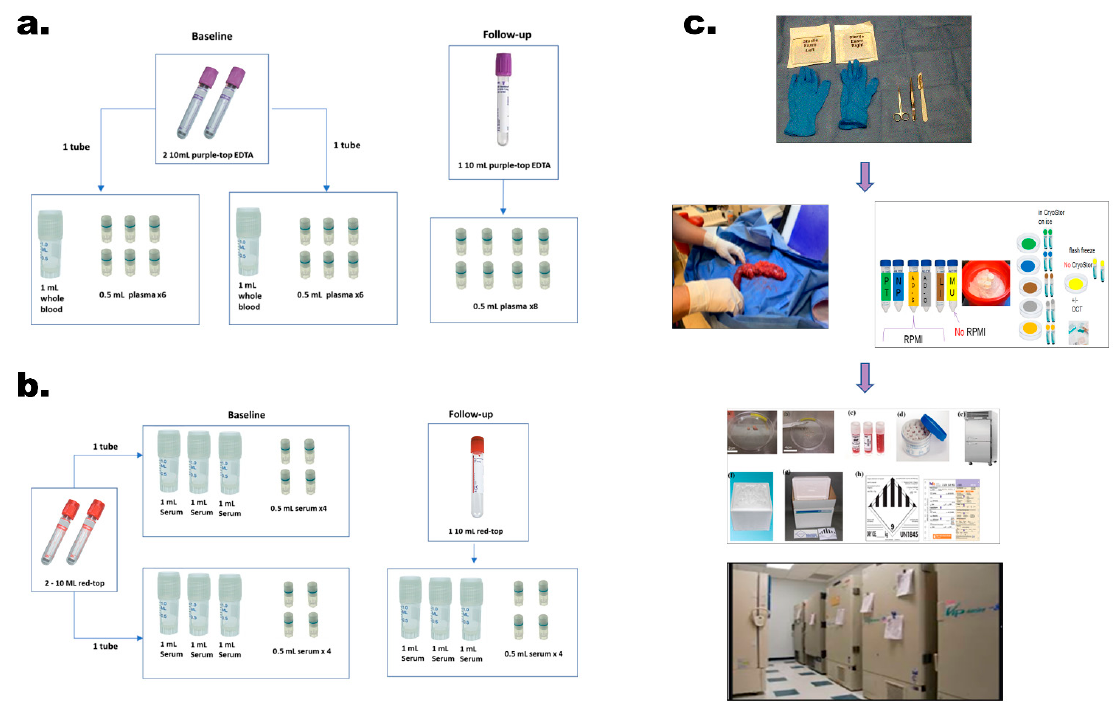
Figure 2. Blood and Tissue Collection and Processing Workflow. ( a ) Purple-topped EDTA tubes are processed and stored at Baseline and Follow-up time-points into whole blood (Baseline) and plasma (Baseline and Follow-up). ( b ) Red-topped tubes are processed and stored at Baseline and Follow-up timepoints into serum. ( c ) During the surgical procedure, a debridement kit containing sterile supplies (gloves, gauze, scissors, forceps, scalpel, and drape) is open in preparation for receiving tissue samples. Collected tissue samples are placed in labelled conical tubes on ice with 20mL RPMI 1640/2% penicillin-streptomycin (Pancreatic Tumor (PT), Normal Pancreas (NP), Adipose–omental (AD-O), Adipose–subcutaneous (AD-S), and Liver (LI), or in an empty conical tube Muscle (MU). Samples are then transferred to labelled petri dishes for mincing. Non-muscle tissues are placed in cryovials with CryoStor CS10 to slow freeze in a Mr. Frosty overnight prior to long-term storage in liquid nitrogen. Muscle tissues are either placed in cryovials with no media and snap frozen prior to long-term storage in a − 80 °C freezer (Step A) or frozen in isopentane, embedded in OCT, and stored in a cassette in a - 80 o C freezer until shipment and future analysis (Step B).